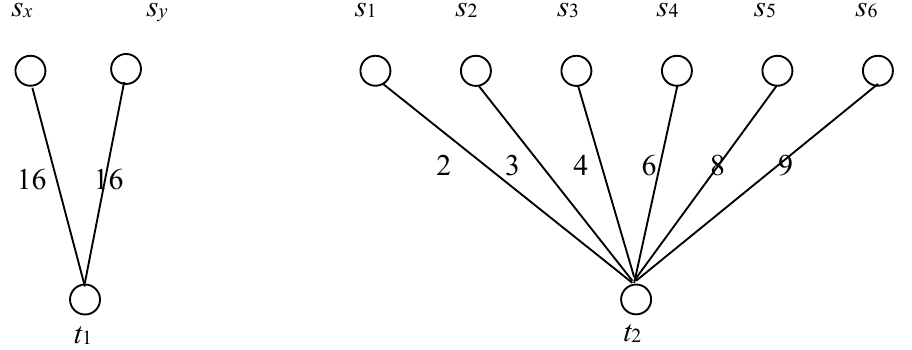
Figure 10. An example of cost-sharing maximum edge coloring problem (CSMECP) constructed from